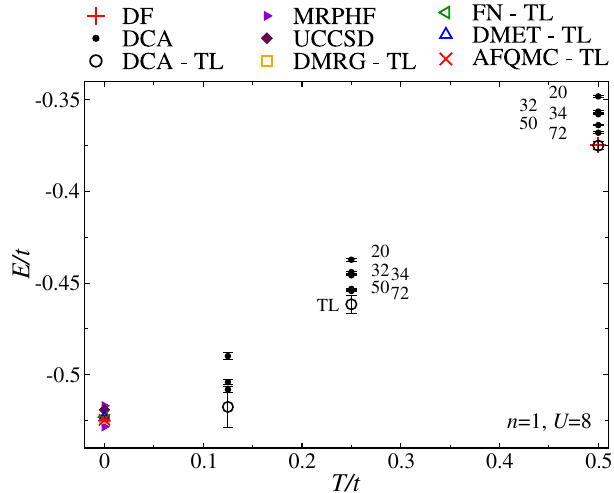
FIG. 3. Temperature dependence of the energy for n ¼ 1 for U=t ¼ 8 obtained by DCA (black circles) and DF (red cross) and compared to zero-temperature results compiled from various techniques. Solid symbols represent finite systems; open symbols represent extrapolations to the TL.